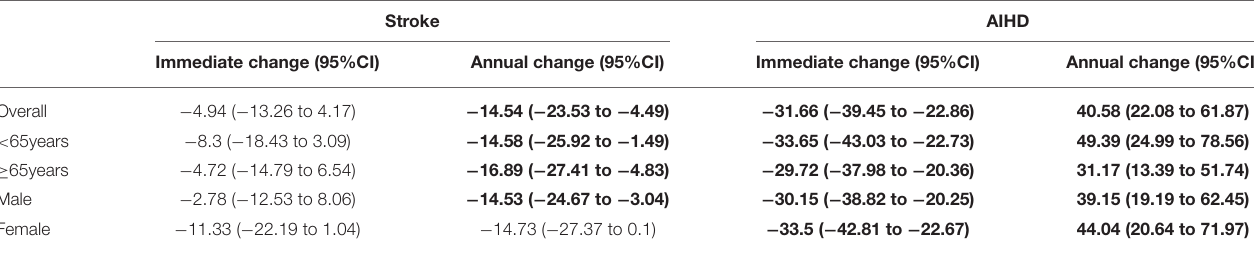
TABLE 2 | Average percentage change * (%) in hospital admission rates of all groups and sex- and age-specific subgroups due to the smoke-free policy in Xi’an, 2017–2019.